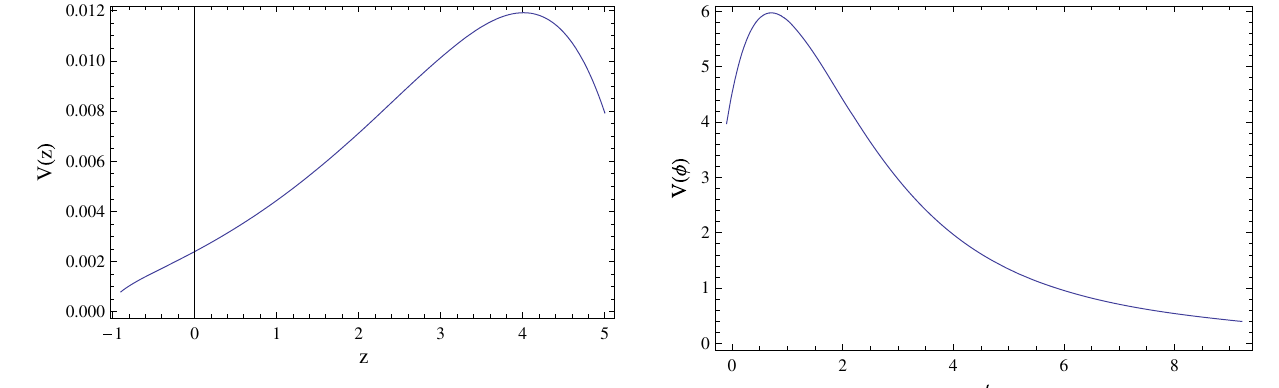
Fig. 6 Variation of V ( z ) with the variation of z (Model I) by consid- ering the best fit values w 0 = − 0 . 737 ,w 1 = 0 . 173